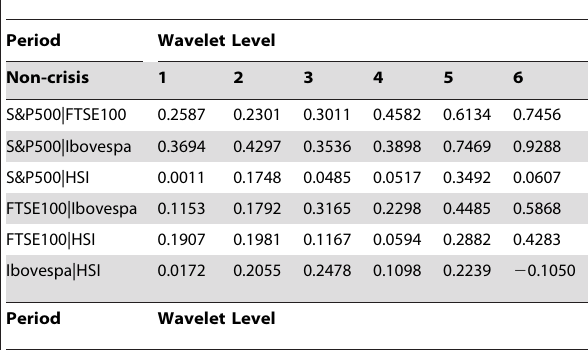
Table 1. Correlations for S&P500, FTSE100, Ibovespa and HSI wavelet coefficients relationships in non-crisis, Sub-prime crisis and Eurozone crisis.